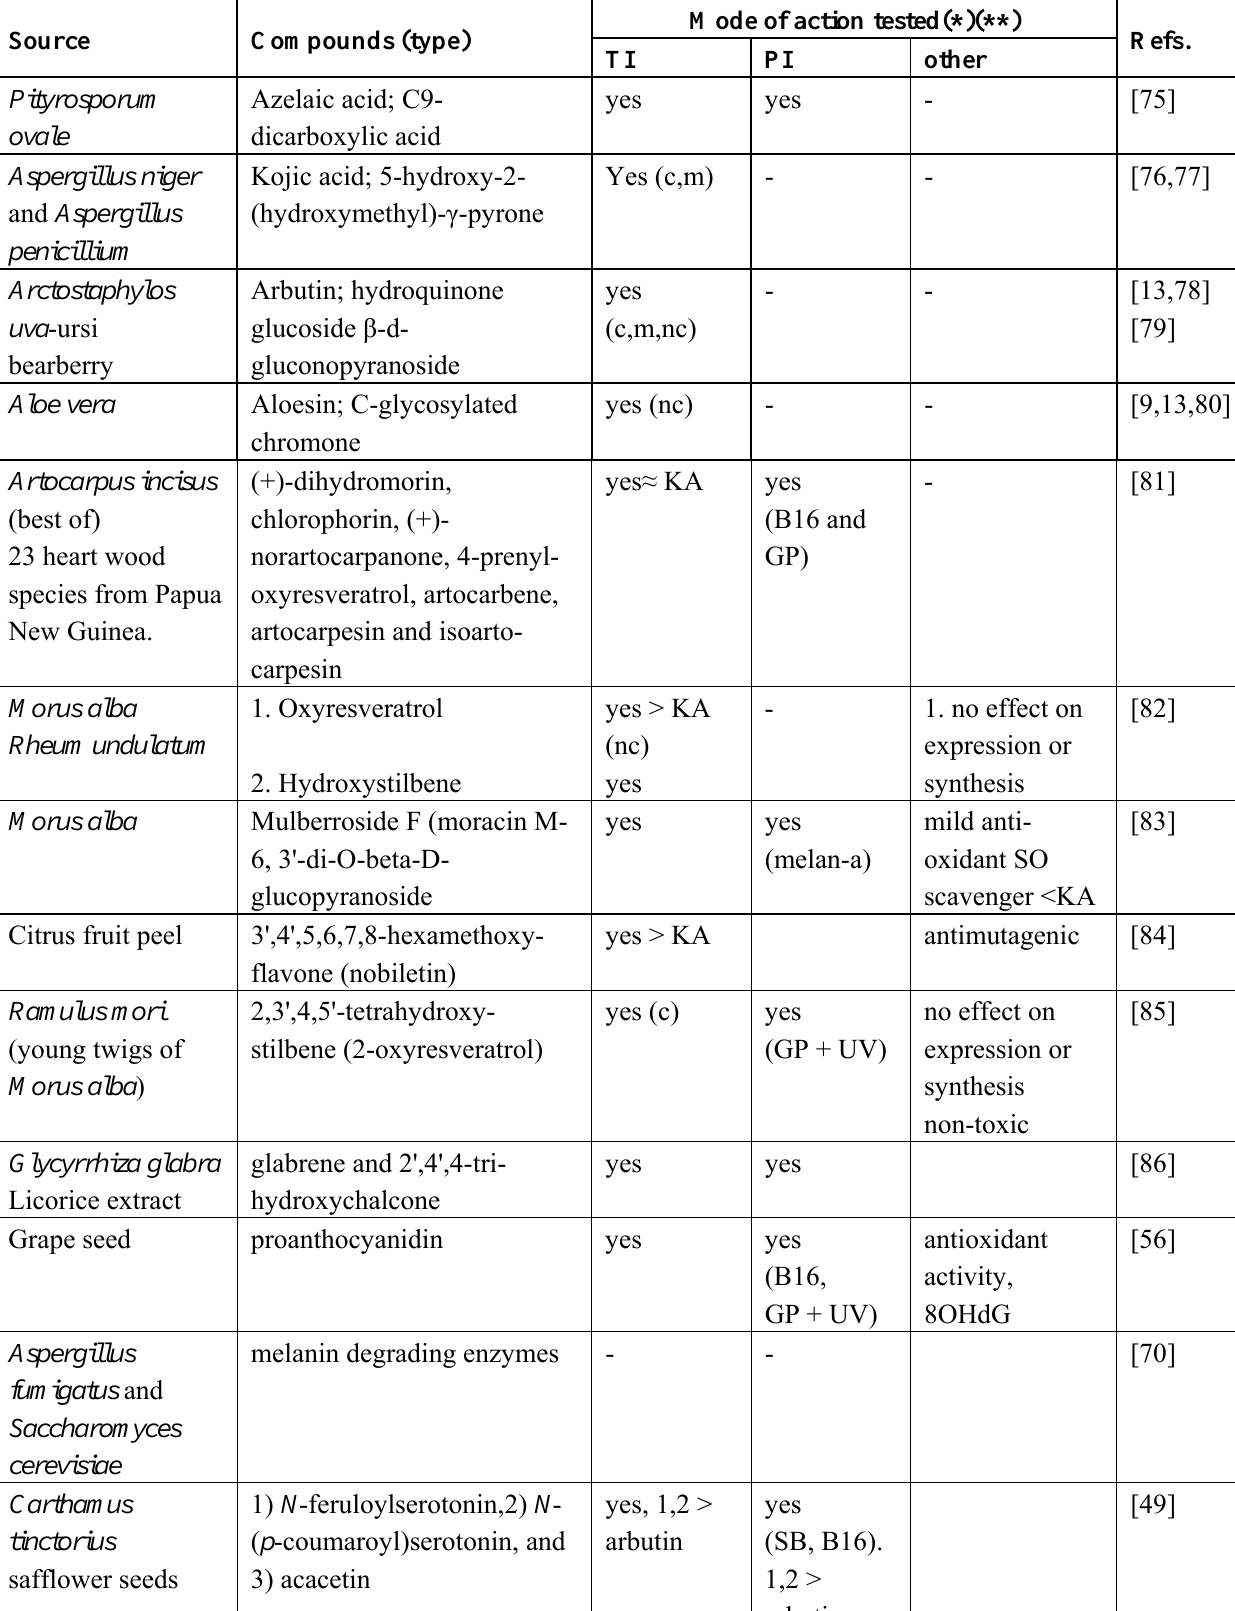
Table 2. New whitening agents from natural sources and their mode of action as tyrosinase inhibitor (TI), inhibitor of pigment synthesis (PI) or by other mechanisms. Azelaic acid, Kojic acid, Arbutin and Aloesin are often used as positive skin whitening